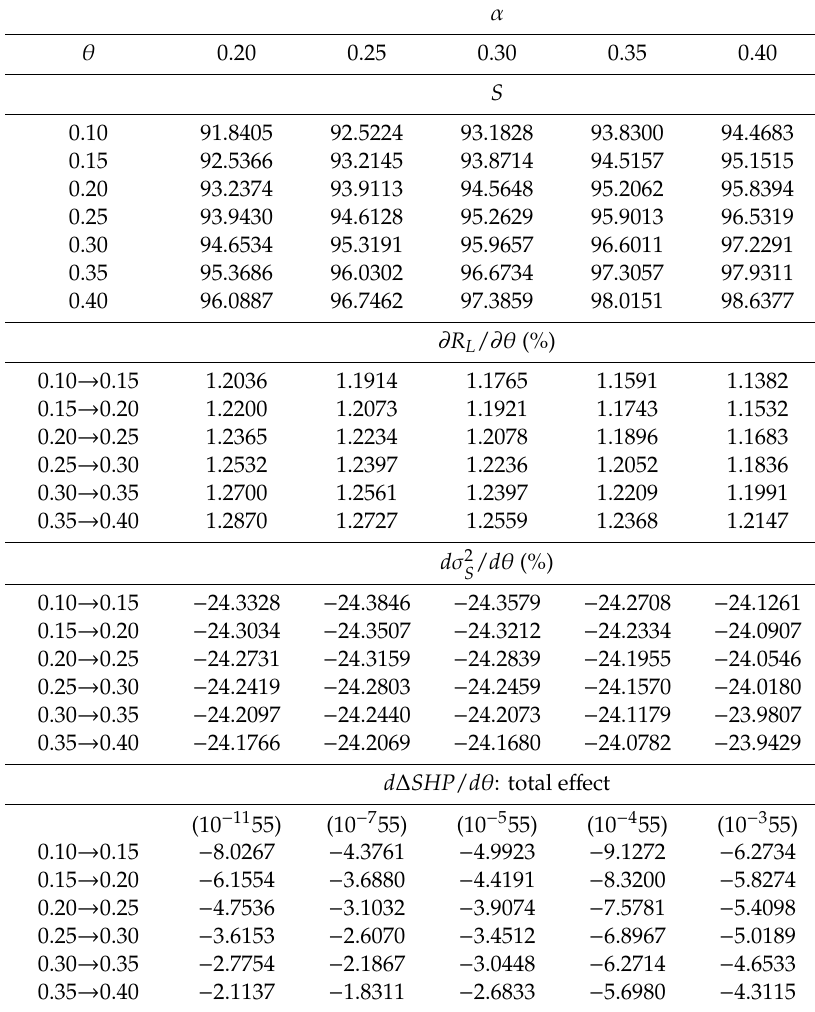
Table 6. E ff ects of government capital injection on diversification e ffi ciency at various levels of international loan portfolio diversification.